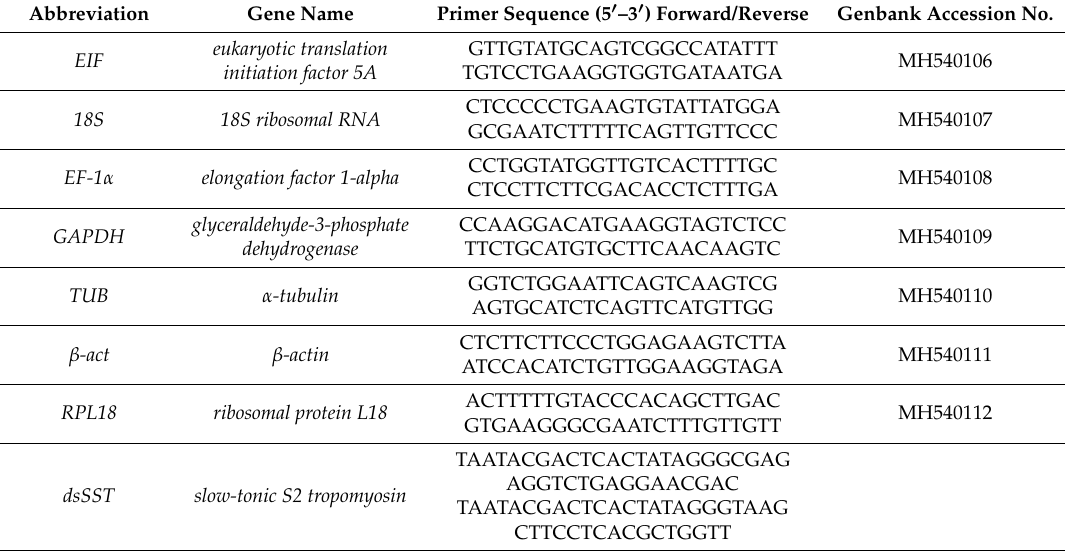
Table A1. Primers for validating open reading